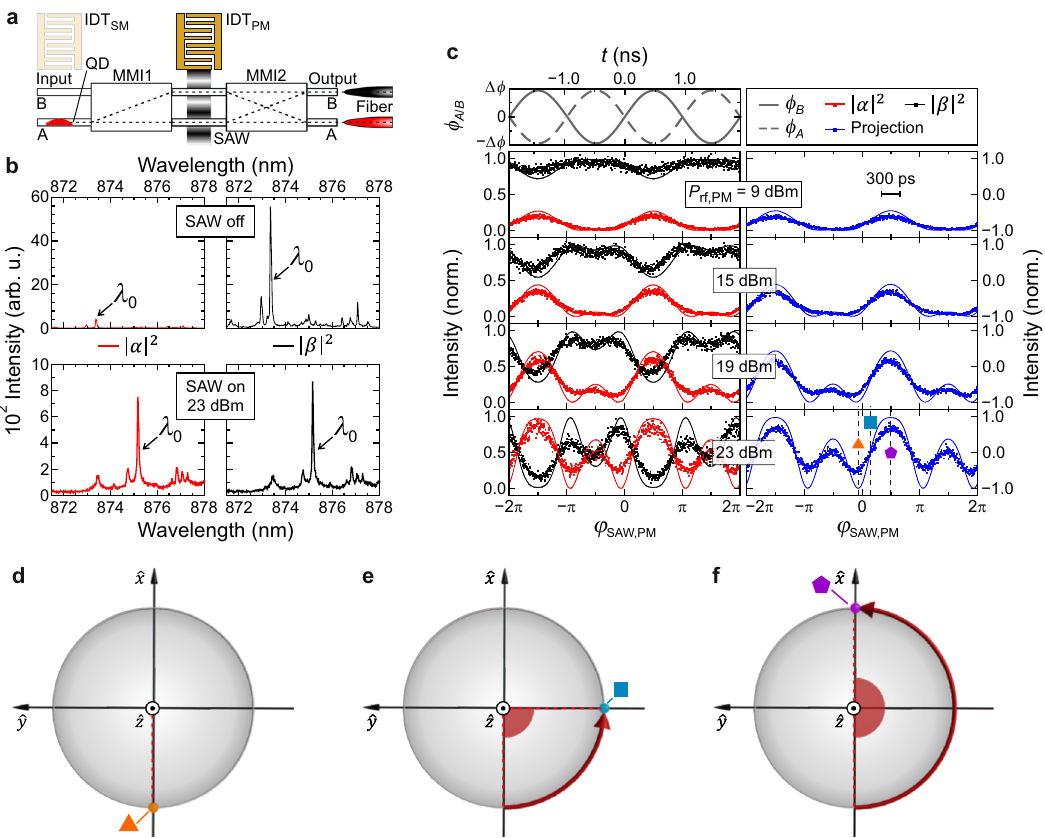
Fig.2|Dynamicroutingofquantumdotemission.a Schematicrepresentationof the experimental con fi guration: although the optical transition of a single QD in Input WG-A is not modulated (IDT SM is inactive), the response of the MZI is modulated(IDT PM isactive)asthephotonspassthrough.Emissioniscollectedbya lensed fi ber from either Output WG-A (red) or Output WG-B (black). b Phase- integrated emission spectra of the same single QD measured without a SAW (top panels, IDT PM off) and an applied SAW ( P rf,PM = 23 dBm, lower panels). c Measured SAWphase-dependentintensityofthemainQDemissionline( λ 0 in b )detectedvia OutputWG-A(redsymbols)andOutputWG-B(blacksymbols)fordifferent P rf,PM as de fi ned by Eq. (6) and Eq. (7). The simulation results (solid lines) for phase